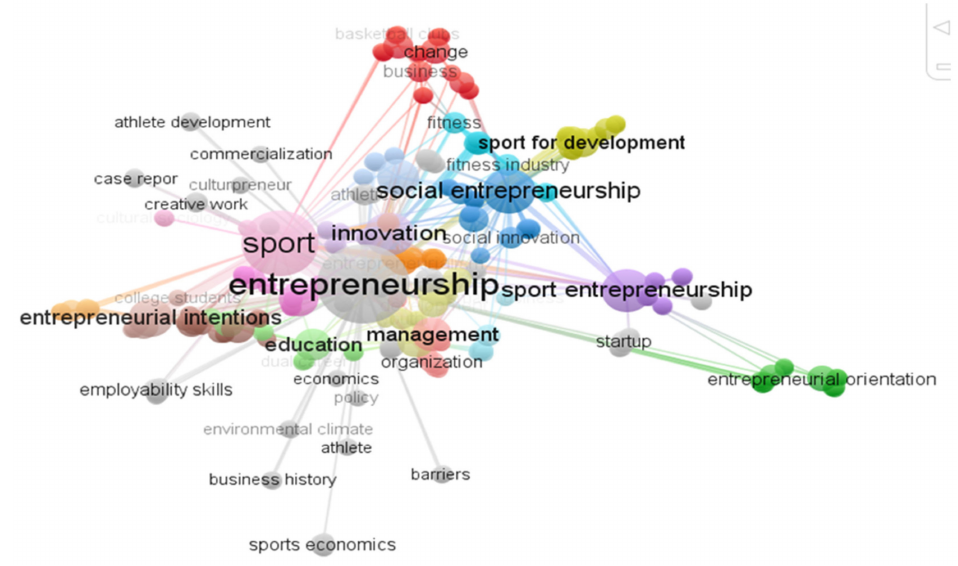
Figure 5. Co-keyword map of the sport entrepreneurship literature (threshold: one co-occurrence).